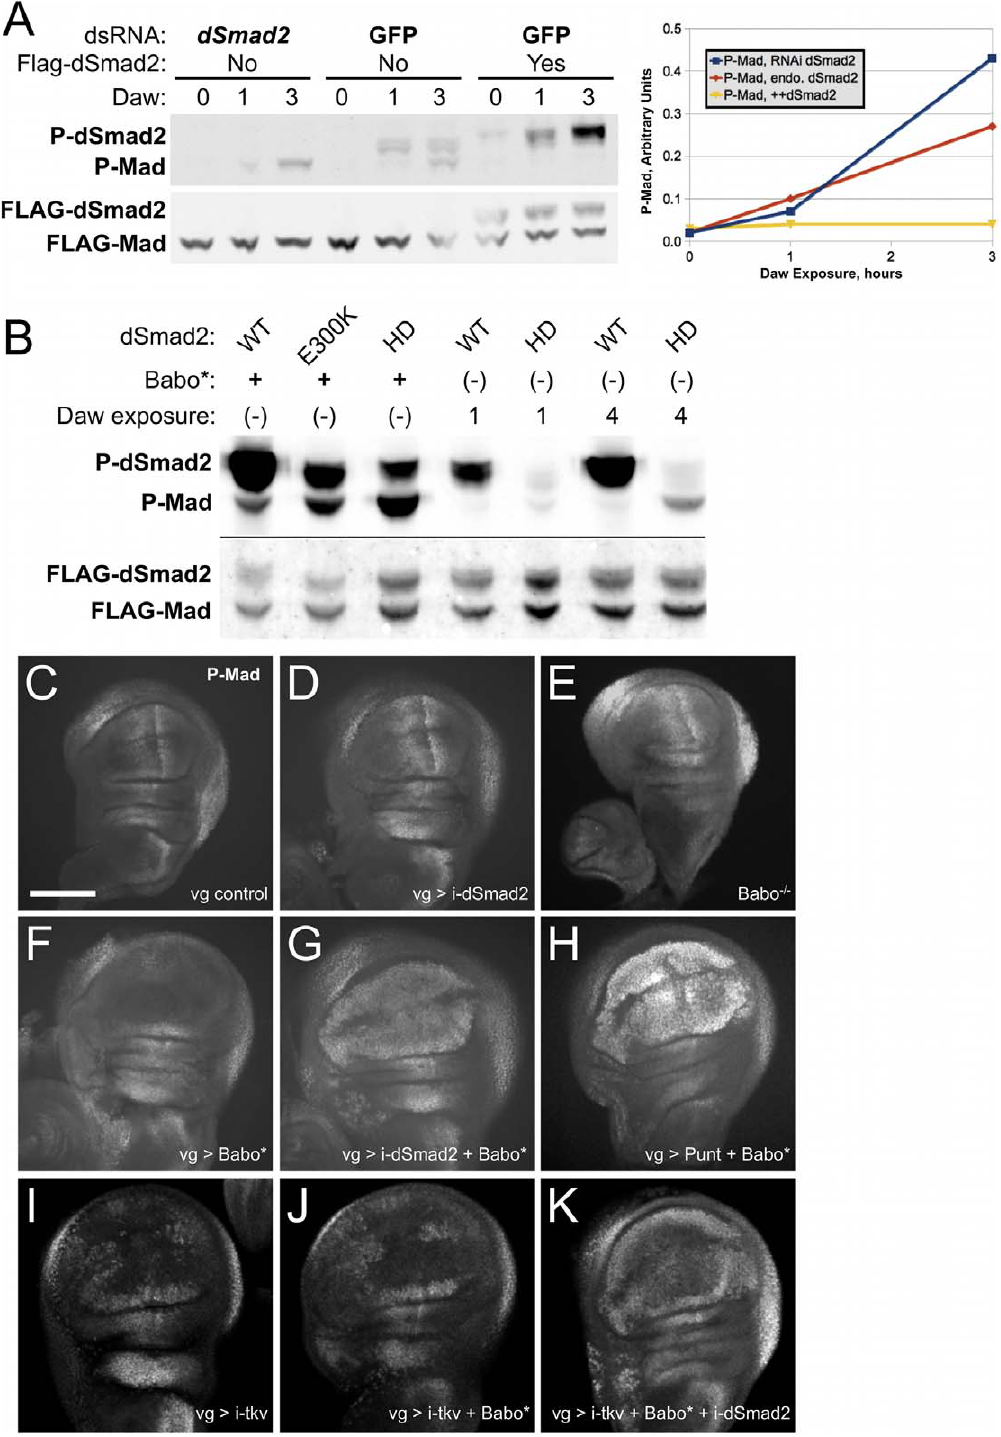
Figure 4. Baboon phosphorylation of Mad is inhibited by dSmad2. (A) Phospho-Smad accumulation upon exposure to Daw ligand. S2 cells transfected with Flag-Mad were treated with dsRNA for dSmad2 or GFP, and transfected with Flag-dSmad2 as indicated. Phospho-Smad and Flag signals were assayed on samples before Daw exposure and after 1 and 3 hours of incubation. Note that there is a gel artifact affecting the appearance of the Flag bands in several lanes. Quantified P-Mad band intensities are plotted to illustrate that accumulation of P-Mad depends on the level of dSmad2. The experiment was repeated with several batches of reporter cells, and the relative signals for the 3 hour time point were always observed in the same order. The 1 hour time points were near background detection and are less reliable due to noise. (B) Mutated dSmad2 proteins with varying phosphorylation efficiency modulate the rate of P-Mad accumulation. Babo* stimulation revealed the steady-state levels of P-dSmad2 and P- Mad. Daw exposure for 1 or 4 hours showed the difference in response to short-term signaling between the WT and HD forms of dSmad2. In both conditions, P-Mad levels were inversely correlated to P-dSmad2 levels. (C–K) Wing imaginal discs from third instar larvae were stained to detect P-Mad